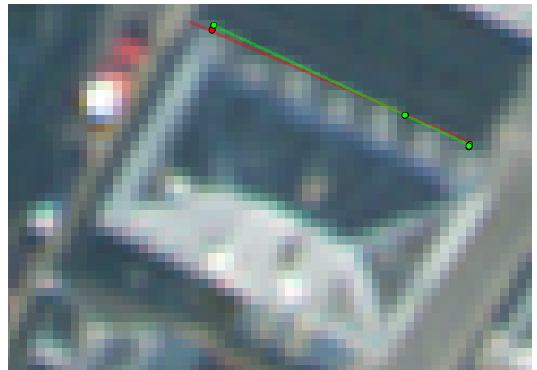
Figure 6: Adjustment results. Extracted points before adjustment (red), after adjustment (green). Segment RMS decreases from 0.37 to 0.27